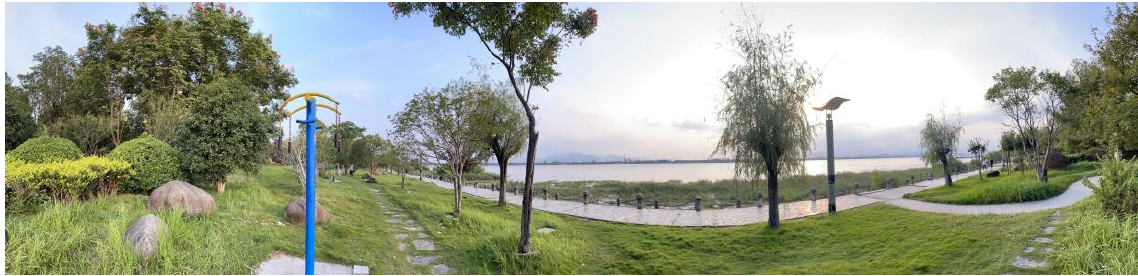
Figure 4. Panoramic picture sample.